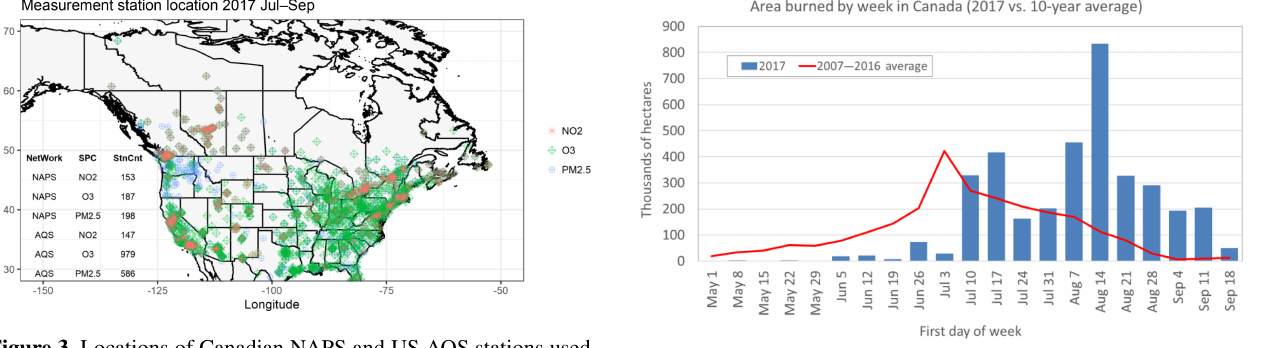
Figure 4. National fire burn area in Canada by week starting for the 2017 fire season (blue vertical bars) and previous 10-year average (red